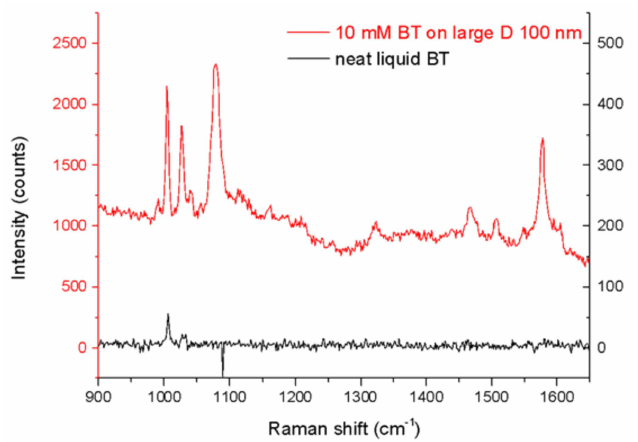
Figure 6. Examples of BT-functionalized Au NHs array (large diameter, 100 nm thick) (red line), and of liquid BT in glass cuvette (black line) Raman